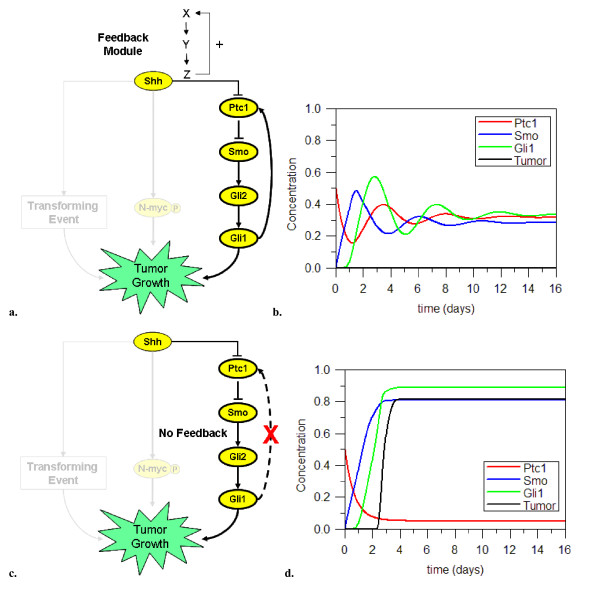
The important role of feedback loops is illustrated by isolating the Shh-to-Gli1 pathway in the hedgehog model. NmycP and the transforming event required for tumor growth are constitutively on in this simulation. a. The feedback from the transcription factor Gli1 to Ptc1 transcriptional activation is operative. As shown in b, Ptc1 transcription is maintained at an equilibrium level that is high enough to keep Gli1 below the threshold required for tumor growth. In c, the feedback is turned off; time courses in d show that increased Gli1 levels no longer influence Ptc1 expression, which is then effectively repressed by Shh. High levels of Gli1 are thus maintained and tumor growth is high. In this simulation Shh is constitutively at its highest level (0.1) and thus not shown.